Question: What form of chart is displayed?
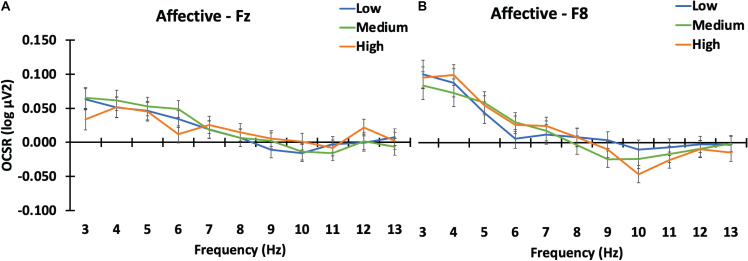
Answer: bar